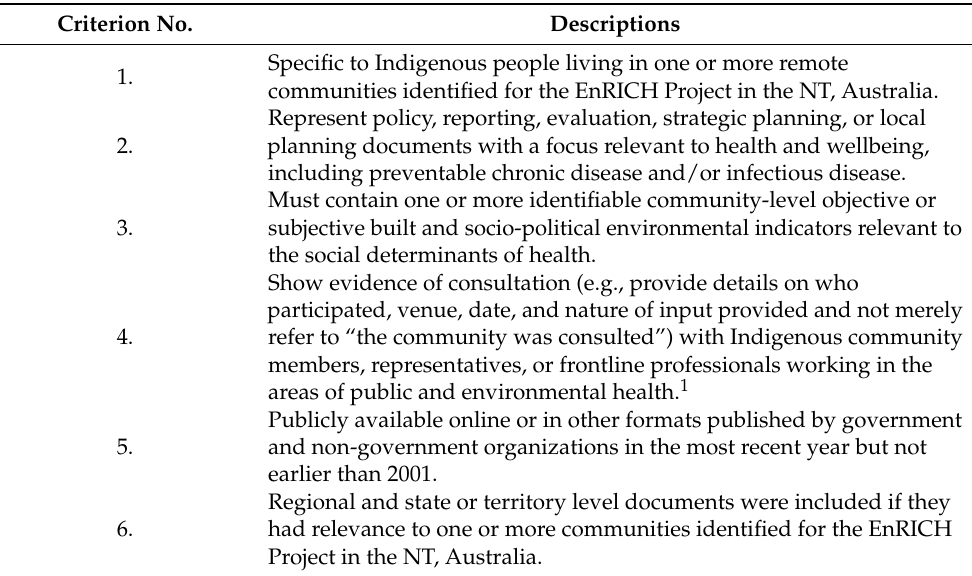
Table 1. Inclusion criteria used for identification and selection of relevant studies. Criterion